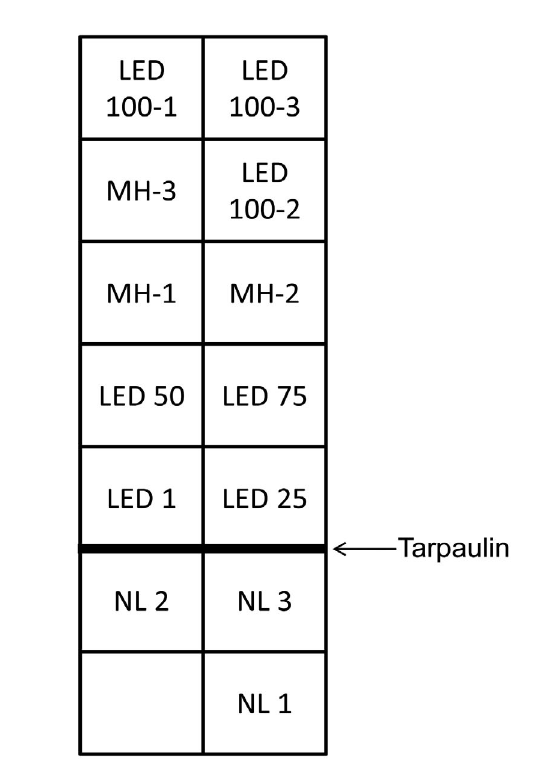
Fig. 1. Overview of the experimental farm with the place- ment of the different experimental cages. Three cages were illuminated by natural light (NL), 3 by submersed 400 W metal halide (MH) lamps and 7 by light-emitting diode (LED) lamps. Three of the LED-lit cages were illuminated with the LED sources at their maximum output (100%), with the remaining 4 LED lamps dimmed down to 75, 50, 25 and 1% (minimum setting possible). See ‘Materials and